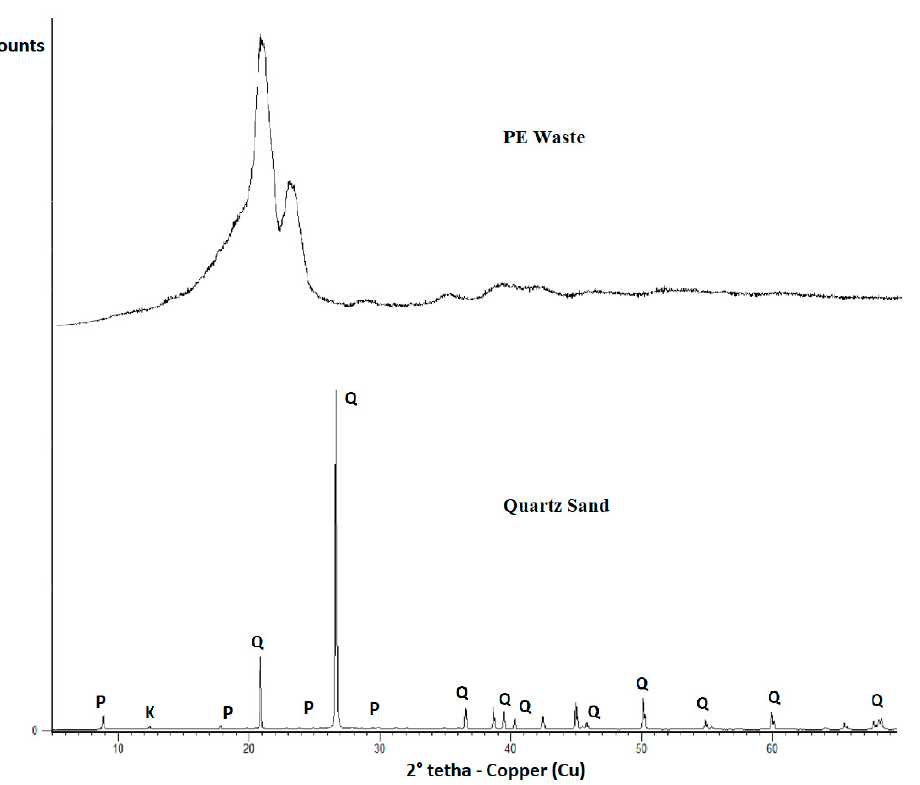
Figure 6. XRD of the PE waste and quartz